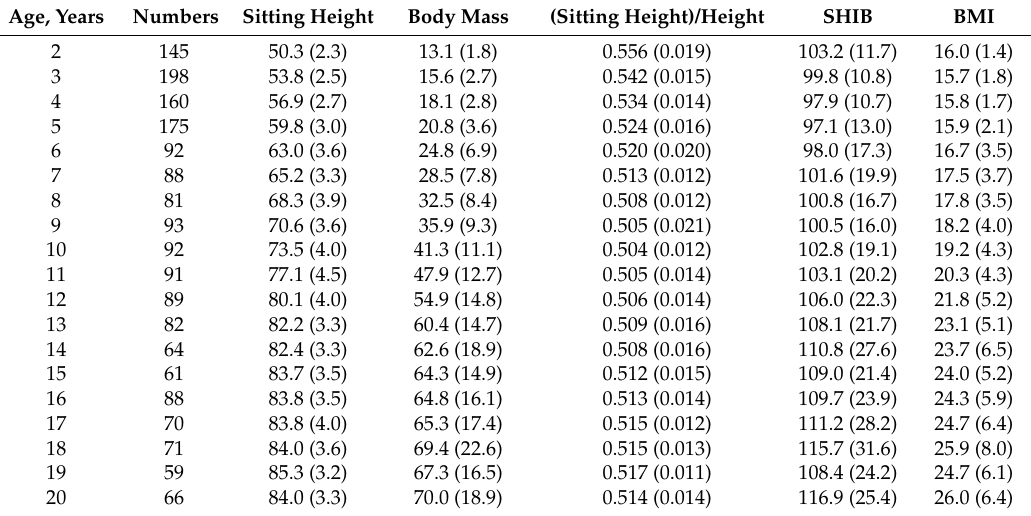
Table 4. Sample sizes and means (with standard deviations in brackets) of sitting height (cm), body mass (kg), ratio of sitting height to standing height, sitting-height index of build (SHIB, kg/m 3 ) and body mass index (BMI, kg/m 2 ) of black females. The data are from the NHANES III laboratory data file